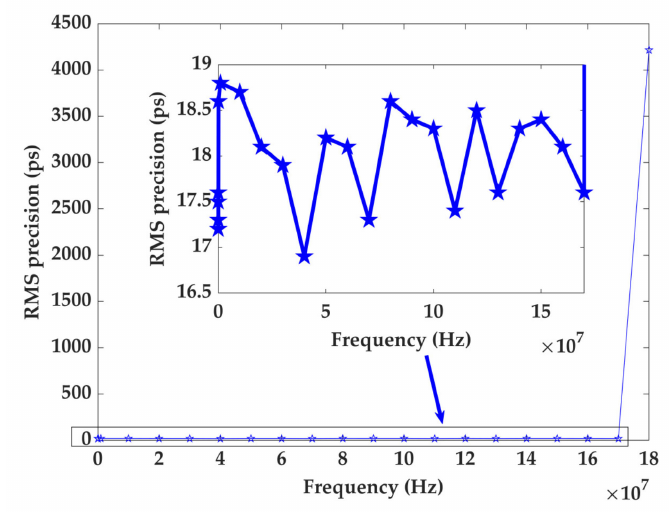
Figure 14. RMS precision of difference frequencies.